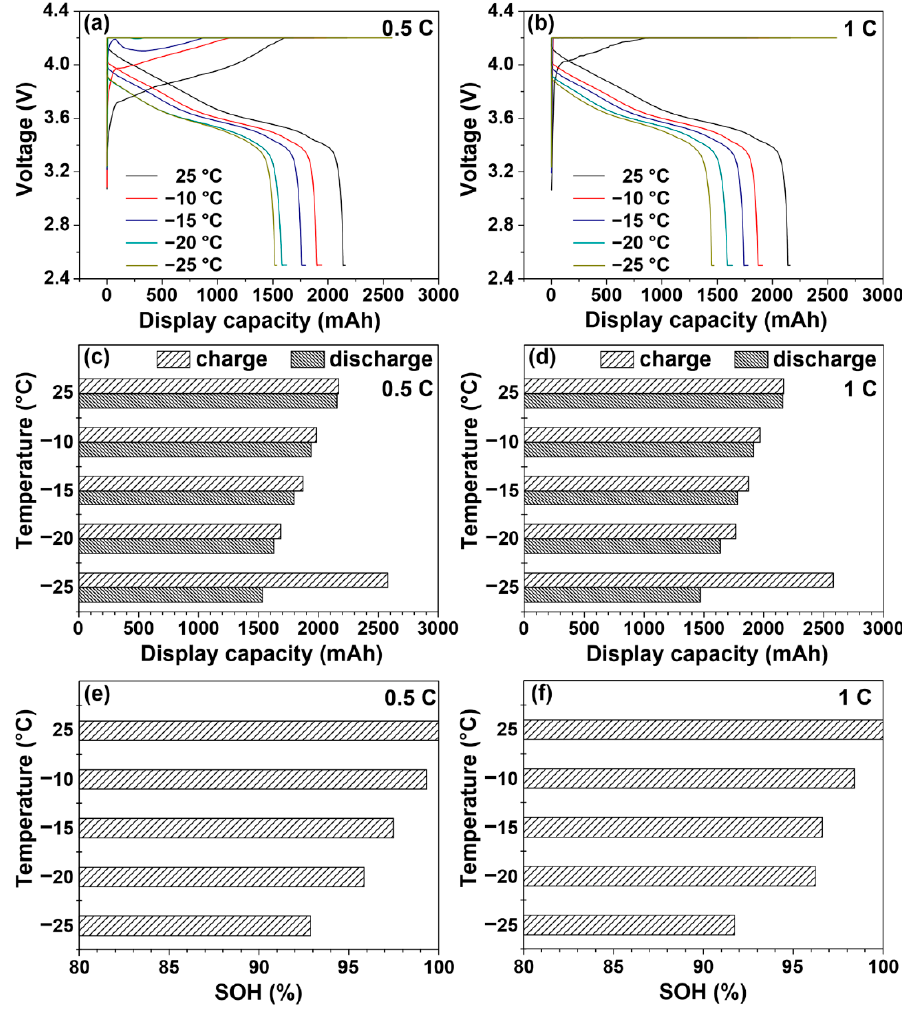
Figure 7. Charge curves at various environmental temperatures ( a ) at 0.5 C and ( b ) at 1 C, and discharge curves at 25 °C at 0.2 C of 18650 lithium-ion battery cells. Final charge and discharge display capacity of these cells: ( c ) at 0.5 C and ( d ) at 1 C. The state of health (SOH) for these cells after charging: ( e ) at 0.5 C and ( f ) at 1 C.